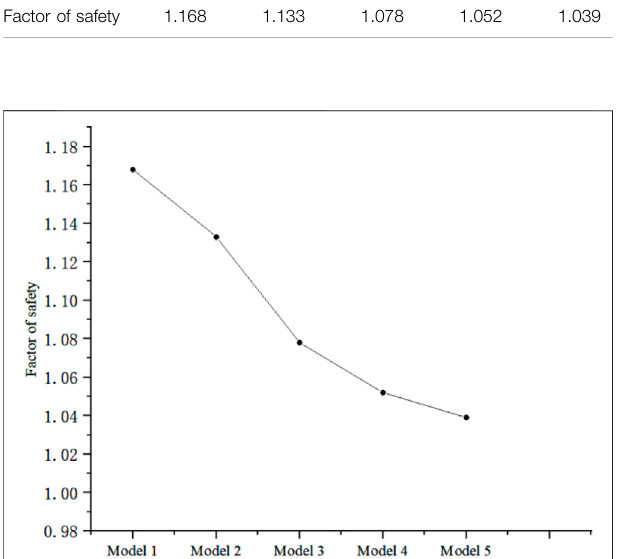
FIGURE 10 | Variation diagram of slope stability coef fi cient with different rainfall